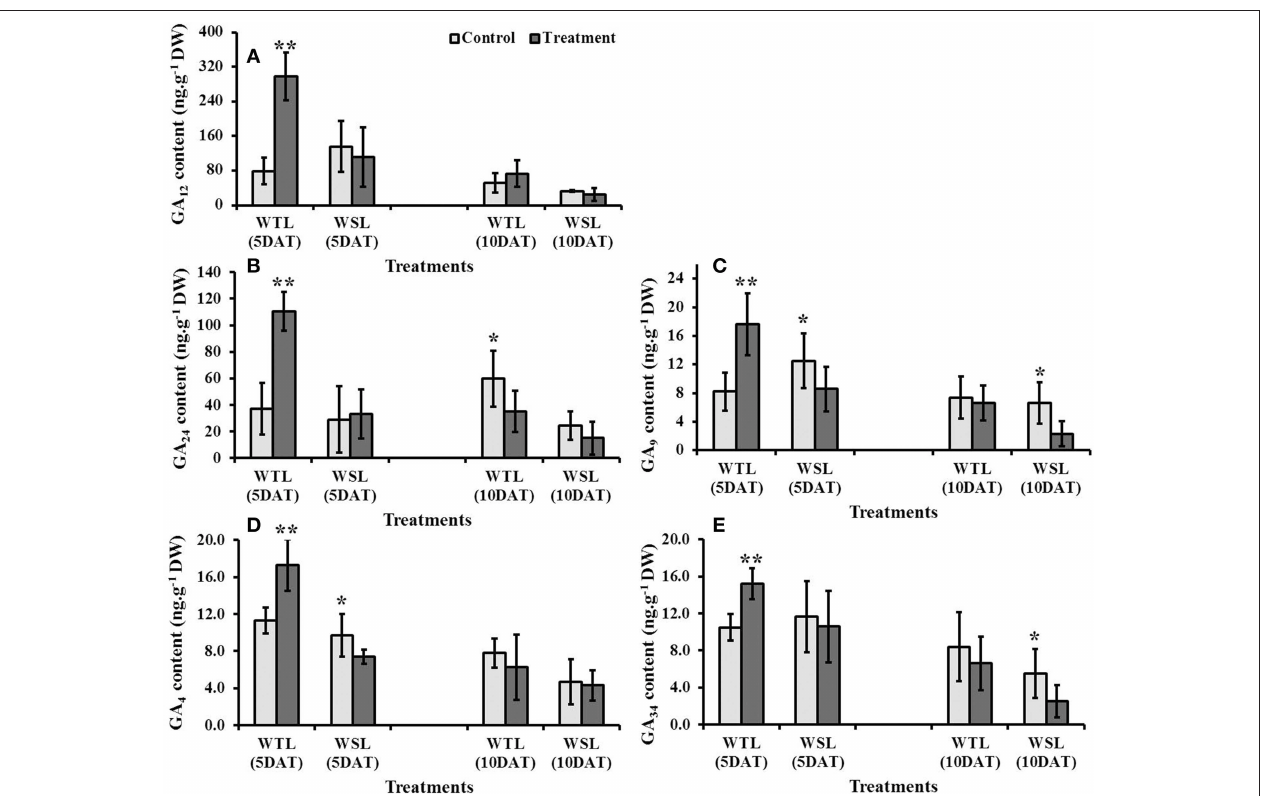
FIGURE 5 | Endogenous gibberellic acid (GA) contents in two soybean lines after waterlogging treatment. The regulation of different gibberellic acids is shown as (A) G 12 , (B) G 24 , (C) GA 9 , (D) GA 4 and (E) GA 34 . In the figures, WTL indicates the waterlogging tolerant line (PI408105A) and WSL revealed waterlogging susceptible line (S99-2281). In the figure, star marks indicated significantly difference between control and treatment at P < 0 . 05 or P < 0 . 01 . Data is the average ± standard error ( n = 3 ).